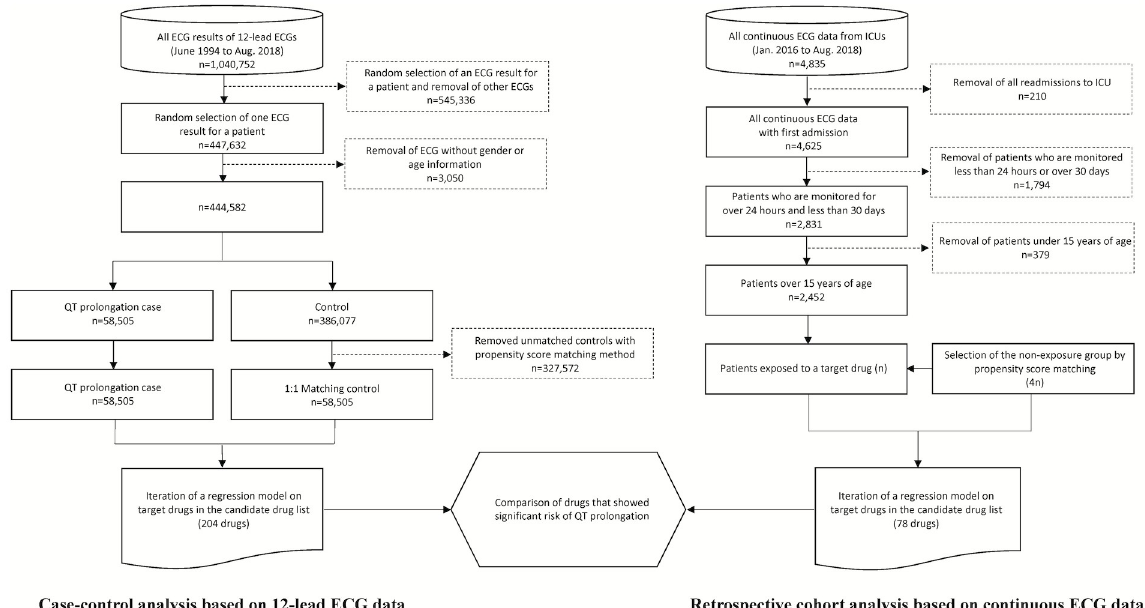
Fig 1. Flow chart of the research